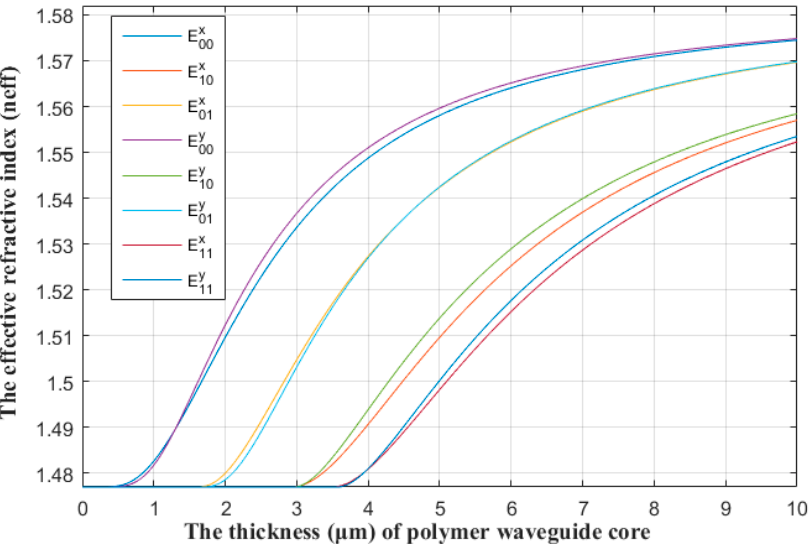
Figure 2. Relationship between the effective refractive index of different modes and the thickness of the polymer waveguide core.